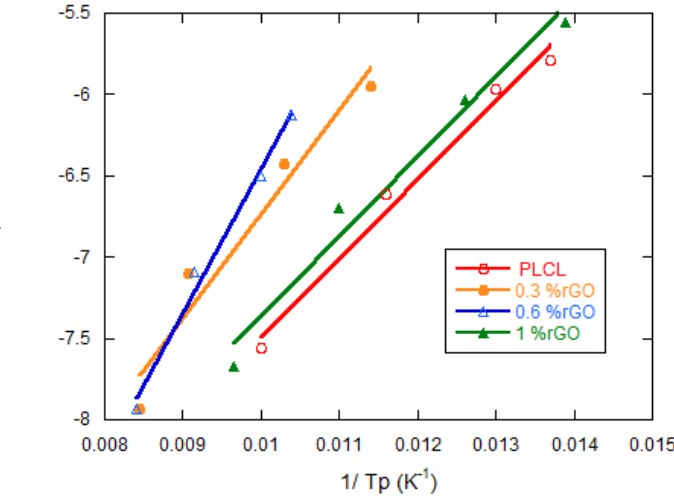
Figure 10. Kissinger plots of PLCL and PLCL/rGO composites for the estimation of crystallization activation energy.